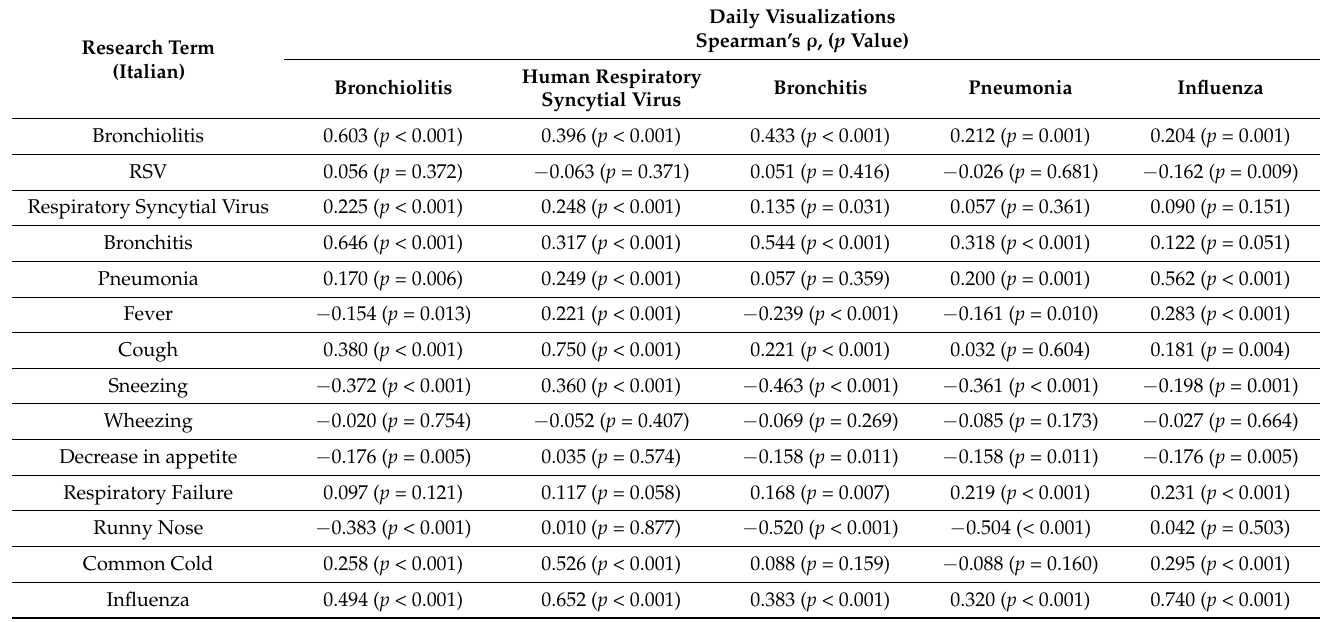
Table A3. Correlation between weekly volume searches on Italian Wikipedia and main keywords from Google Trends TM .